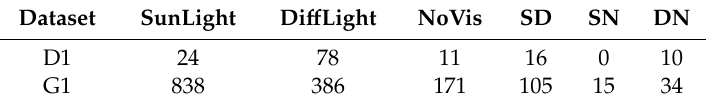
Table 3. Number of images manually classified for datasets D1 and G1.